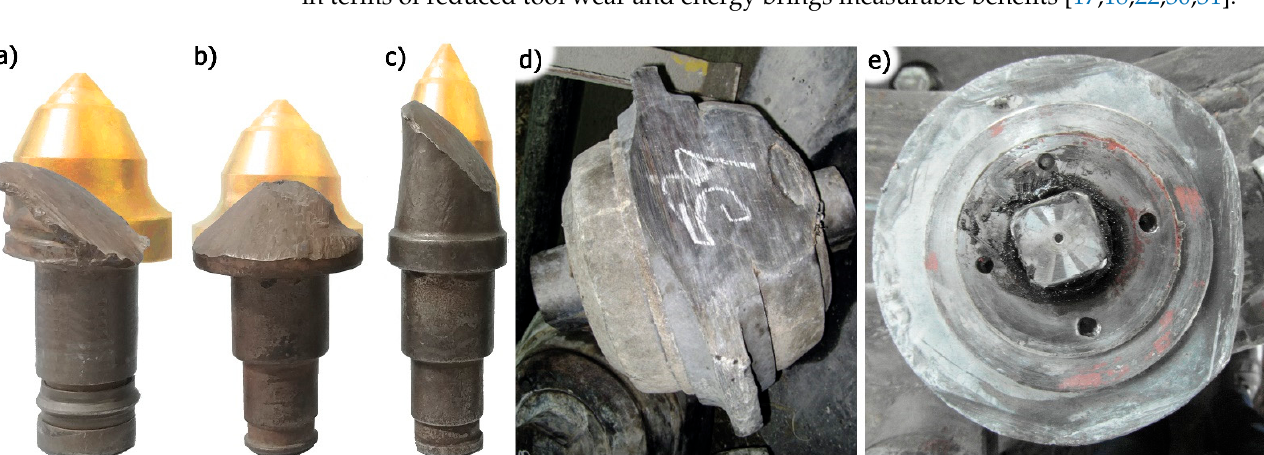
4 of 18 Figure 3. Mining methods based on the use of conical picks and discs: ( a ). cutting [29], ( a ). static